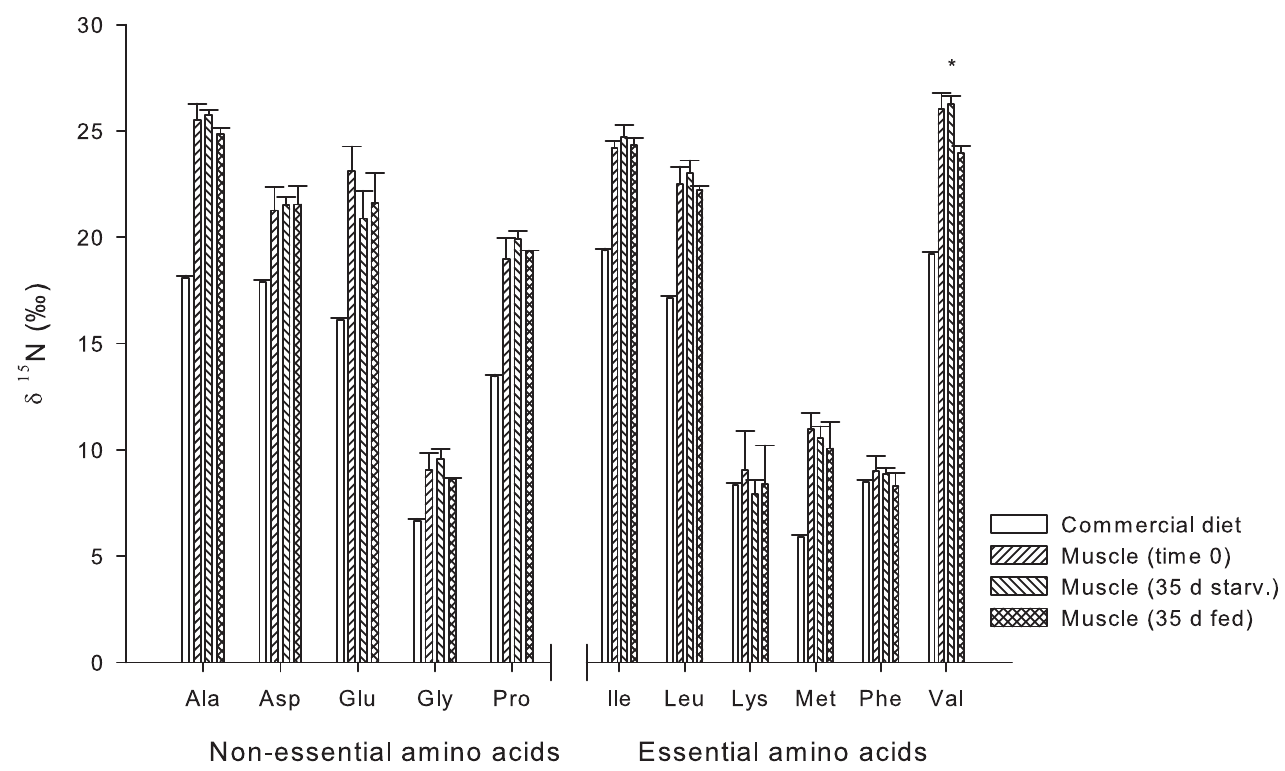
Fig 5. Compound specific δ 15 N of amino acids of S . lalandi muscle: Commercial diet, Time 0, Muscle 35 d starvation and Muscle 35 d fed, averageand standard deviation. Asterix ( * ) denotesstatisticallysignificantdifference betweentime 0 and 35 days of starvation.